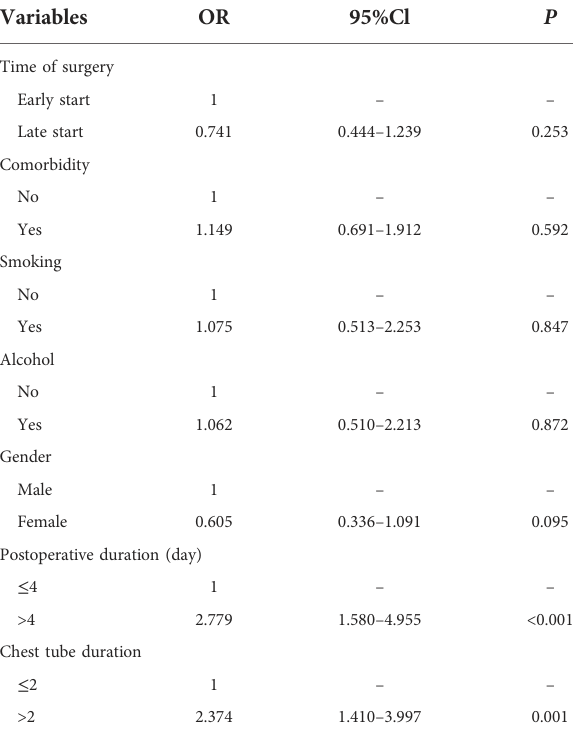
TABLE 4 Multivariable logistic regression analysis of total hospital cost.